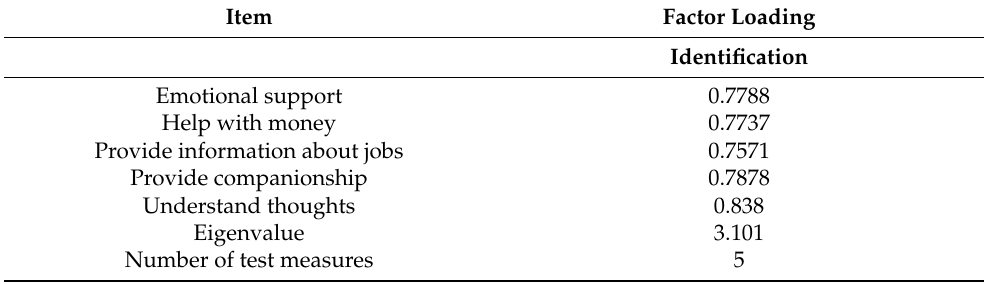
Table 5. Summary of results from exploratory factor analysis of bridging social capital.